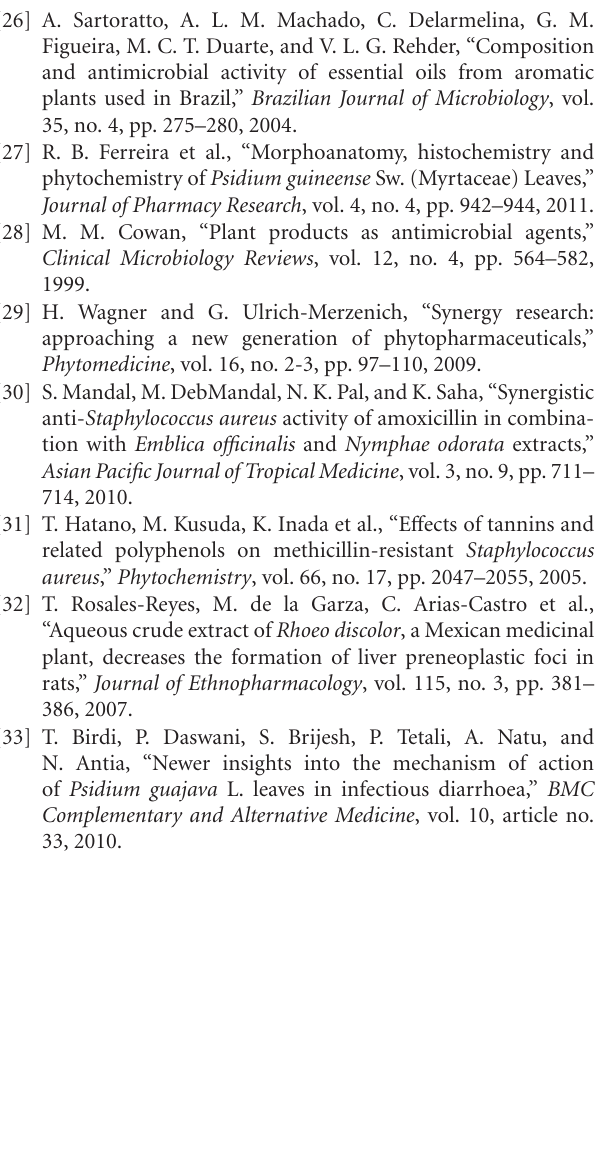
Figueira, M. C. T. Duarte, and V. L. G. Rehder, “Composition and antimicrobial activity of essential oils from